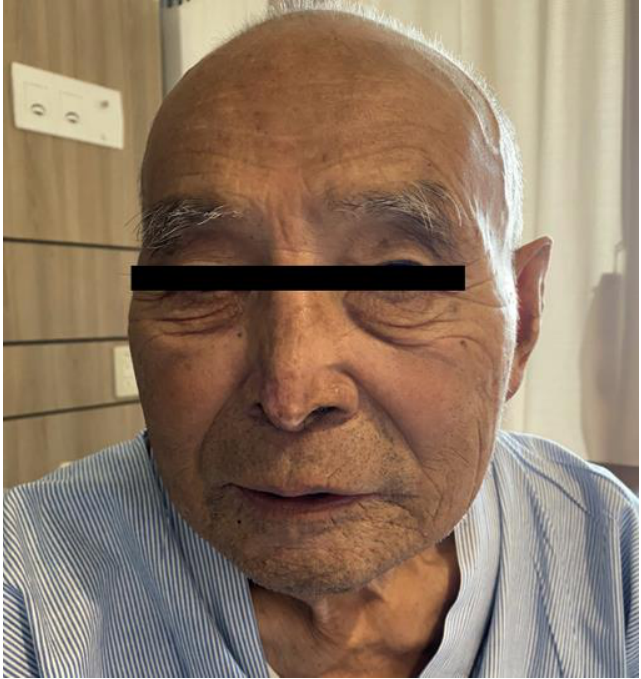
Figure 2. After treatment with 1 mg/kg/day of prednisolone (PSL). After a 1-week treatment, we decreased the dose to 0.5 mg/kg/day. His symptoms did not worsen; thus, the PSL dosage was gradually reduced to 10 mg/week. After the